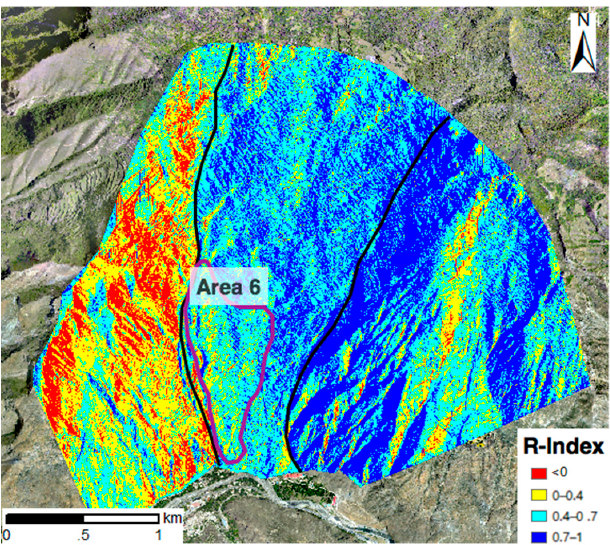
Figure 6. The R-index map of the Xishancun Landslide for the descending geometry.